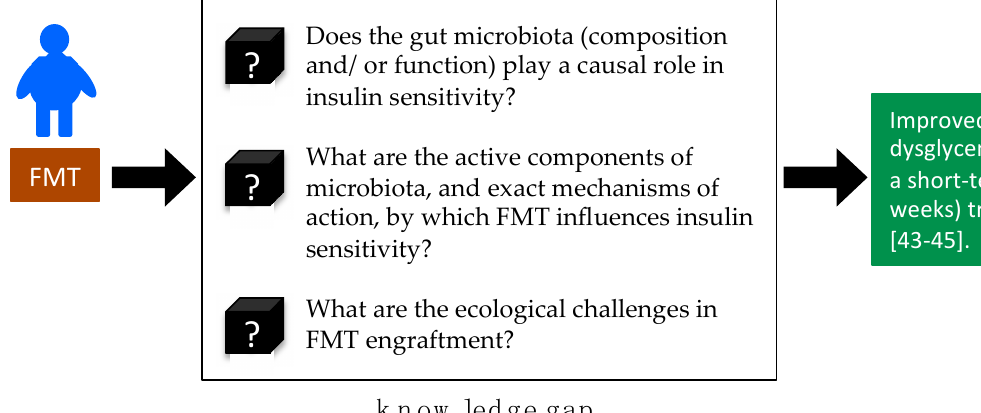
Figure 2. Mechanistic aspects of fecal microbiota transplantation (FMT) in obesity and metabolic 255 syndrome (MS) requiring targeted research. 256